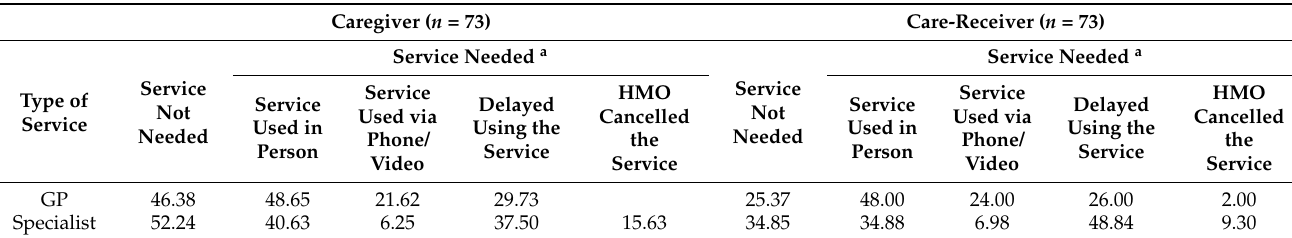
Table 2. Need and use of healthcare services in Israel’s basket of services